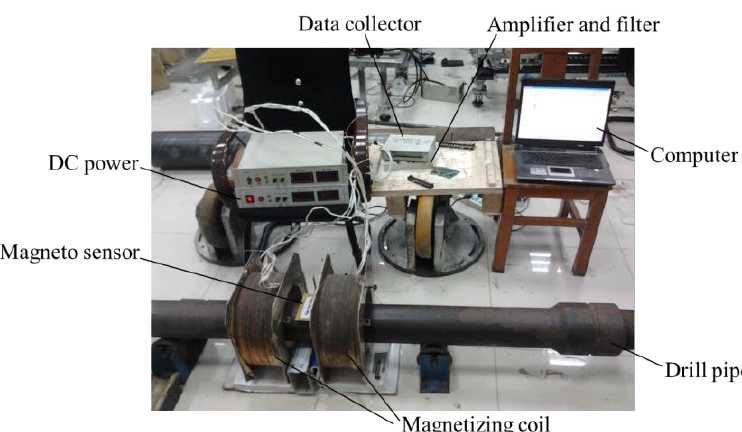
Figure 7. The experiment setup of the lift-off-tolerant MFL probe for drill pipes.